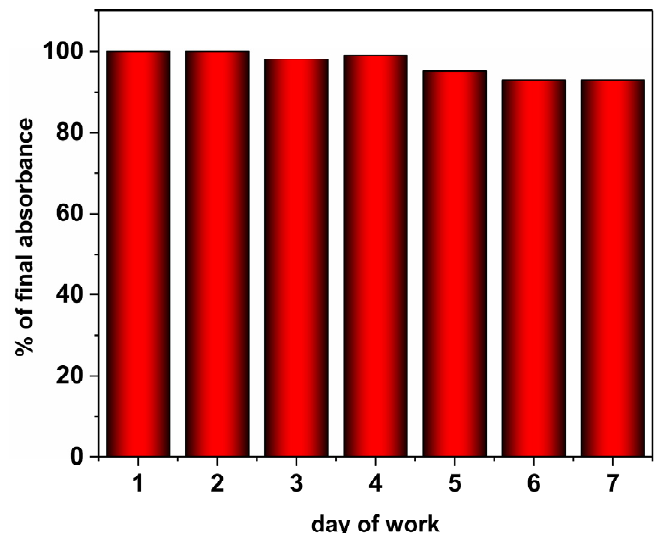
Figure 8. Changes in the final absorbance during seven days of work with the same